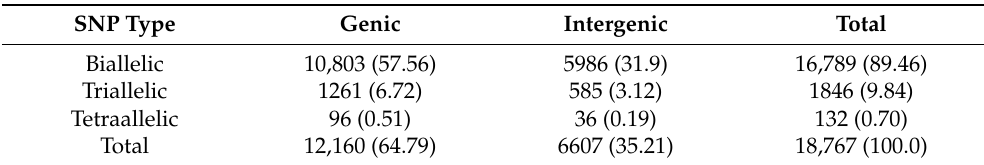
Table 3. Number of SNP types, percentage and distribution in genic and intergenic regions of the Epiphyas postvittana genome.